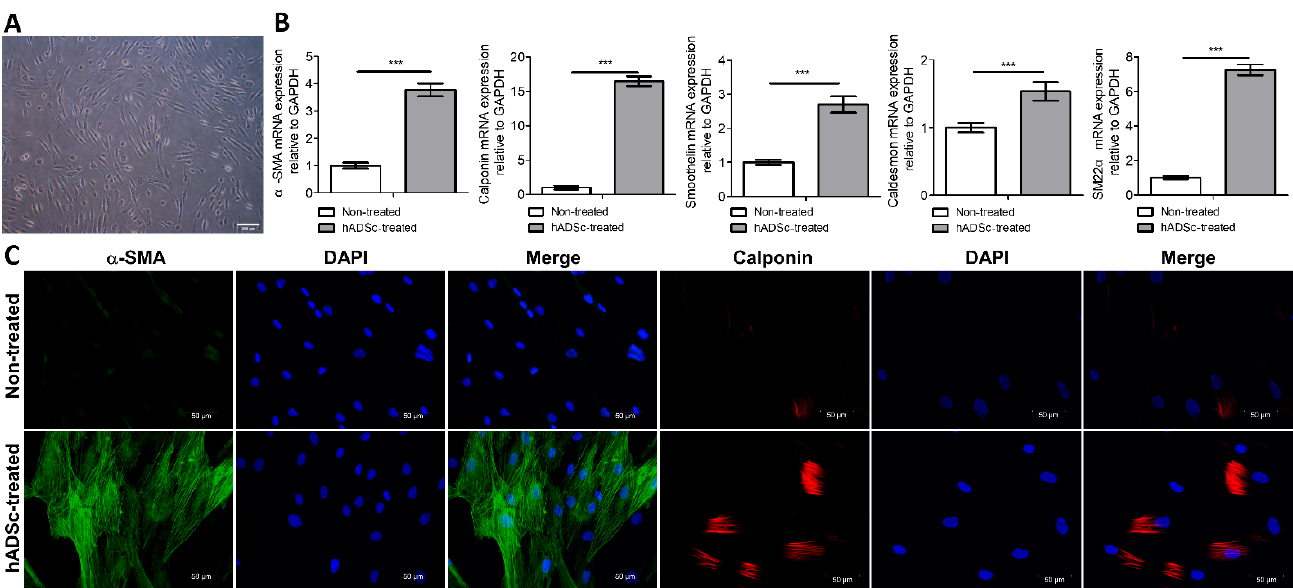
Figure 2. In vitro differentiation of hADScs into SMCs. ( A ) Optimal differentiation into SMCs was observed after two weeks when cells were cultured in smooth muscle inductive medium (low-glucose DMEM containing 0.1% gentamicin plus 5 ng/mL TGF- β ). 2D-cultured hADScs in uncoated dishes grew to confluence and formed a monolayer of fibroblast-like cells presenting a flat morphology and a stress fiber pattern. ( B ) RT–PCR analysis of α -SMA , calponin , smoothelin , caldesmon , and SM22 α levels between the hADSc-treated group and the control group after cell differentiation. ( C ) Immunofluorescence staining of α -SMA and calponin expression after cell differentiation. SMC, smooth muscle cell; TGF- β , transforming growth factor β ; hADSc, human adipose-derived stem cell; RT-PCR, real-time polymerase chain reaction; α -SMA, α -smooth muscle actin; GAPDH, glyceraldehyde 3-phosphate dehydrogenase. Data are expressed as the mean ± SD; *** p < 0.001.